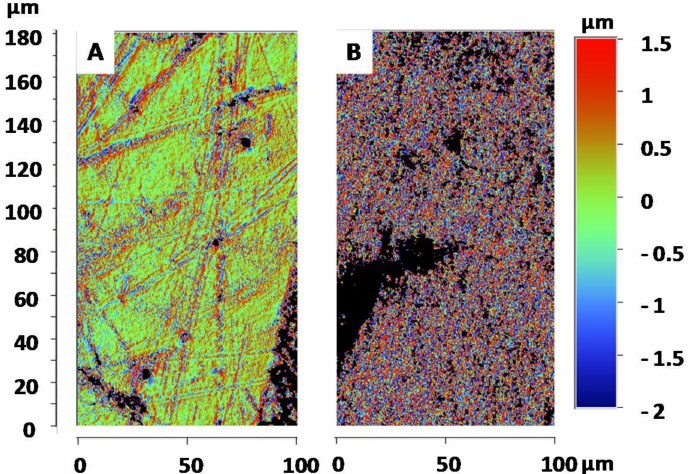
Figure 6. Representative profilometer images observed for the ( A ) white and ( B ) black parts of the G. orientalis